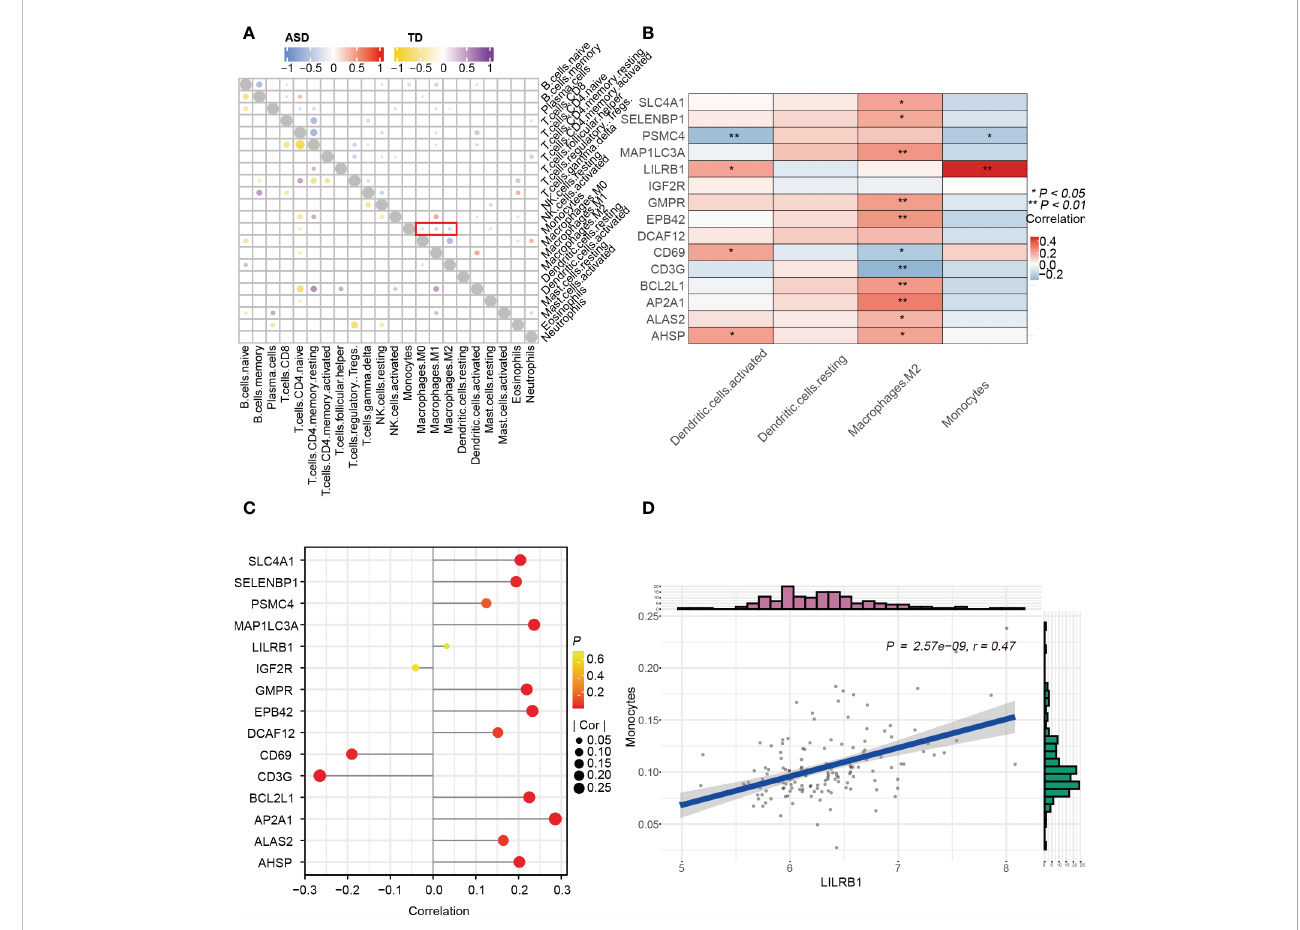
FIGURE 8 Correlation between immune cells and genes. (A) Correlation between 15 hub genes and 4 signi fi cantly differential immune cells. (B) Lollipop diagram of the correlation between 15 hub genes and M2 Macrophages with |r| > 0.20, p < 0.05. (C) Correlation among immune cells in the child ASD and TD groups. (D) Scatter plot of signi fi cantly related LIlRB1 and monocytes with r > 0.40 and p < 0.001. * p < 0.05; ** p <